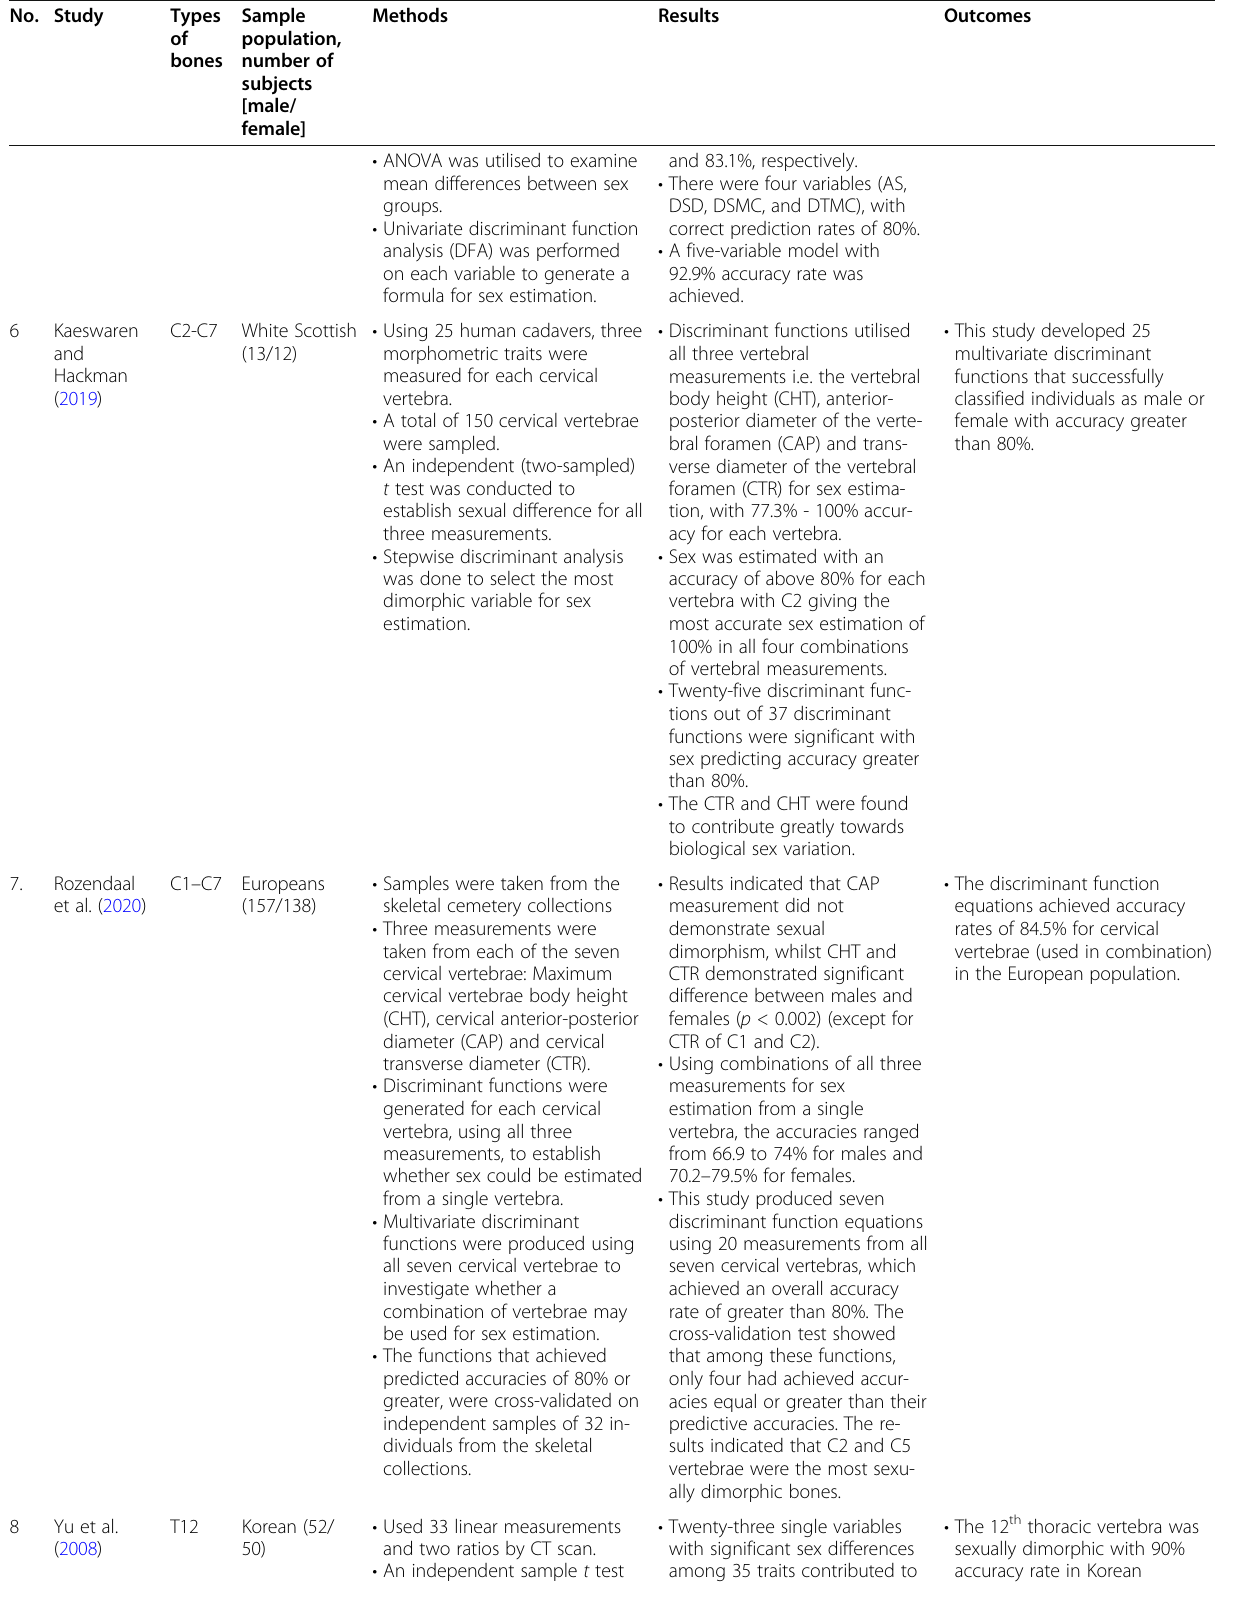
Table 1 The descriptive studies on sexual dimorphism in vertebral bone (Continued) No.